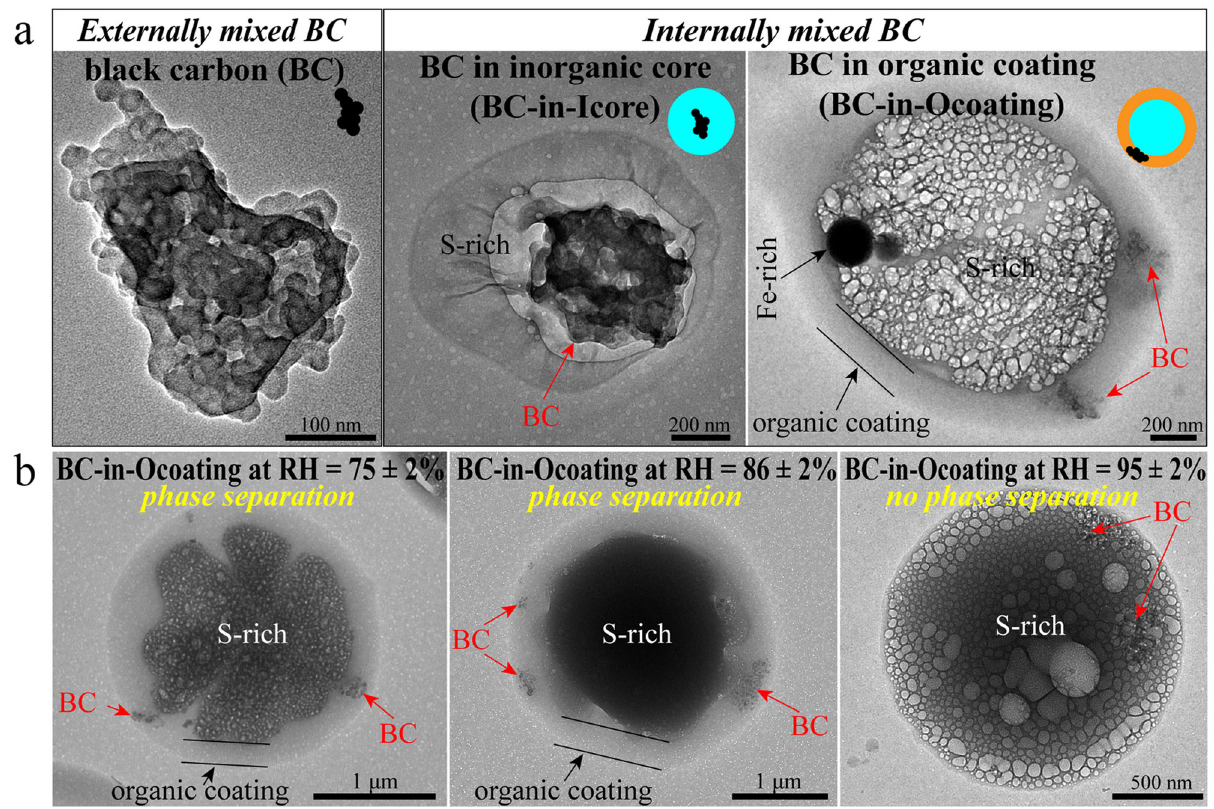
Fig. 1 Typical transmission electron microscopy (TEM) and cryogenic TEM (cryo-TEM) images of black carbon (BC)-containing particles with different mixing structures. a TEM images of externally mixed BC particle, BC in S-rich (BC-in-Icore) particle, and BC in organic coating (BC-in-Ocoating) particle. The mixing models of BC-containing particles are shown in the upper right corners of the TEM images. The black circle aggregates, cyan circles, and orange rings represent BC, S-rich, and organic coatings, respectively. b Cryo-TEM images of BC-in-Ocoating particles. These particles were exposed to atmospheric conditions with different relative humidity (RH) = 75 ± 2%, 86 ± 2%, and 95 ± 2% for 10 min before being frozen, respectively. The BC-in- Ocoating particles at RH of 75 ± 2% and 86 ± 2% remained liquid-liquid phase separation (LLPS) between organic matter and inorganic salts. The LLPS of the BC-in-Ocoating particle disappeared when it was at 95 ± 2% RH.